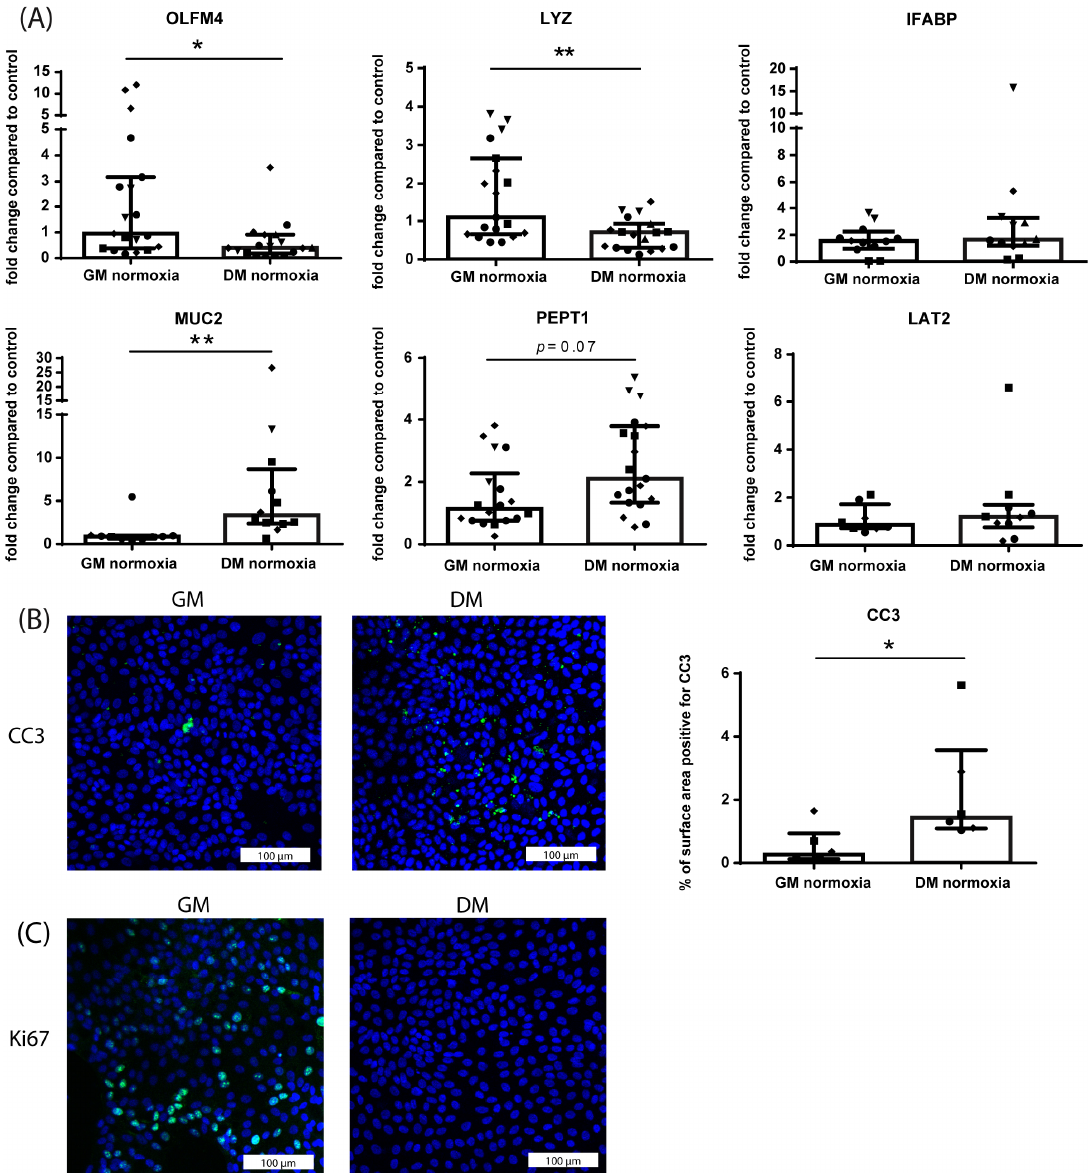
Figure 2. Effects of 60 h culturing with DM on HIO monolayers compared to GM-cultured controls. ( A ) mRNA expression of crypt cell markers OLFM4 (stem cells) and LYZ (Paneth cells), villus cell markers IFABP (enterocytes), MUC2 (Goblet cells) and PEPT1 (enterocytes) and LAT2 (amino acid transporter). Data are reported as relative expression compared to GM (set at 1) and displayed as median with interquartile range. Results were obtained from three different HIO donors (depicted by different data point symbols, one symbol type per donor). * p ≤ 0.05, ** p ≤ 0.01. ( B ) Representative images of immunofluorescence staining of CC3 in HIO monolayers cultured with GM or DM for 60 h and analysis of the % surface area positive for CC3 in both groups. Data are displayed as median with interquartile range. Results were obtained from three different HIO donors (depicted by dif- ferent data point symbols, one symbol type per donor). Scale bars indicate 100 μ m. * p ≤ 0.05. ( C ) Representative images of immunofluorescence staining of Ki67 in HIO monolayers cultured with GM or DM for 60 h. Results were obtained from three different HIO donors. Scale bars indicate 100